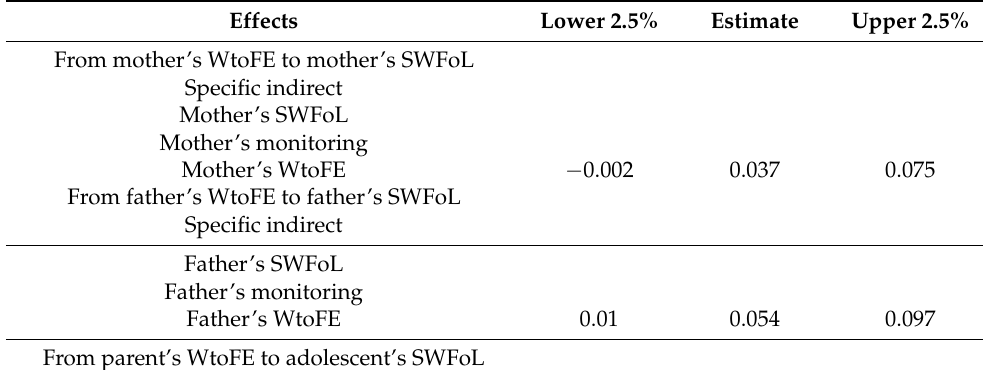
Table 4. Bias-corrected confidence intervals of specific mediation effects of the three family members’ monitoring (the perception regarding parents’ monitoring practices in